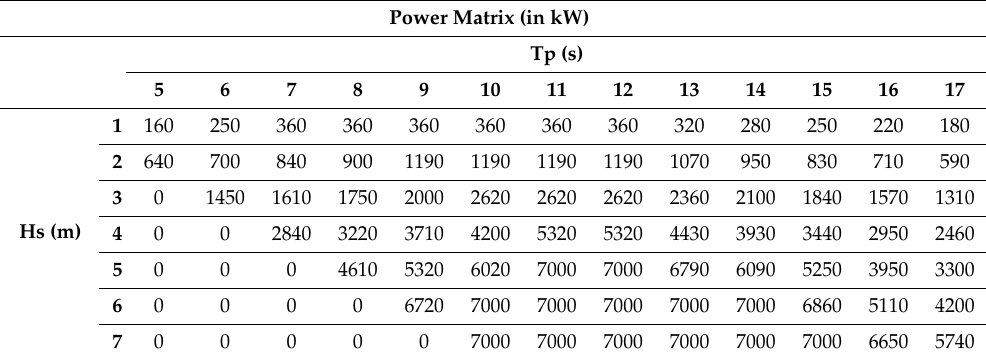
Table 4. Power matrix of D3, Hs being the significant wave height and Tp the peak period [60].